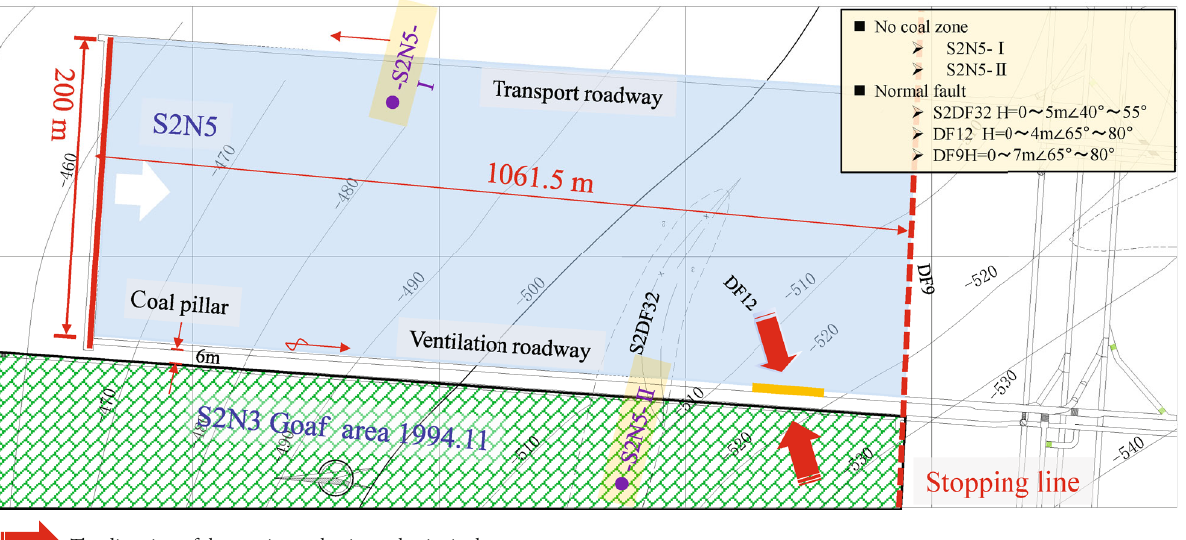
The direction of the maximum horizontal principal stress Figure 2: Basic situation of the S2N5 working